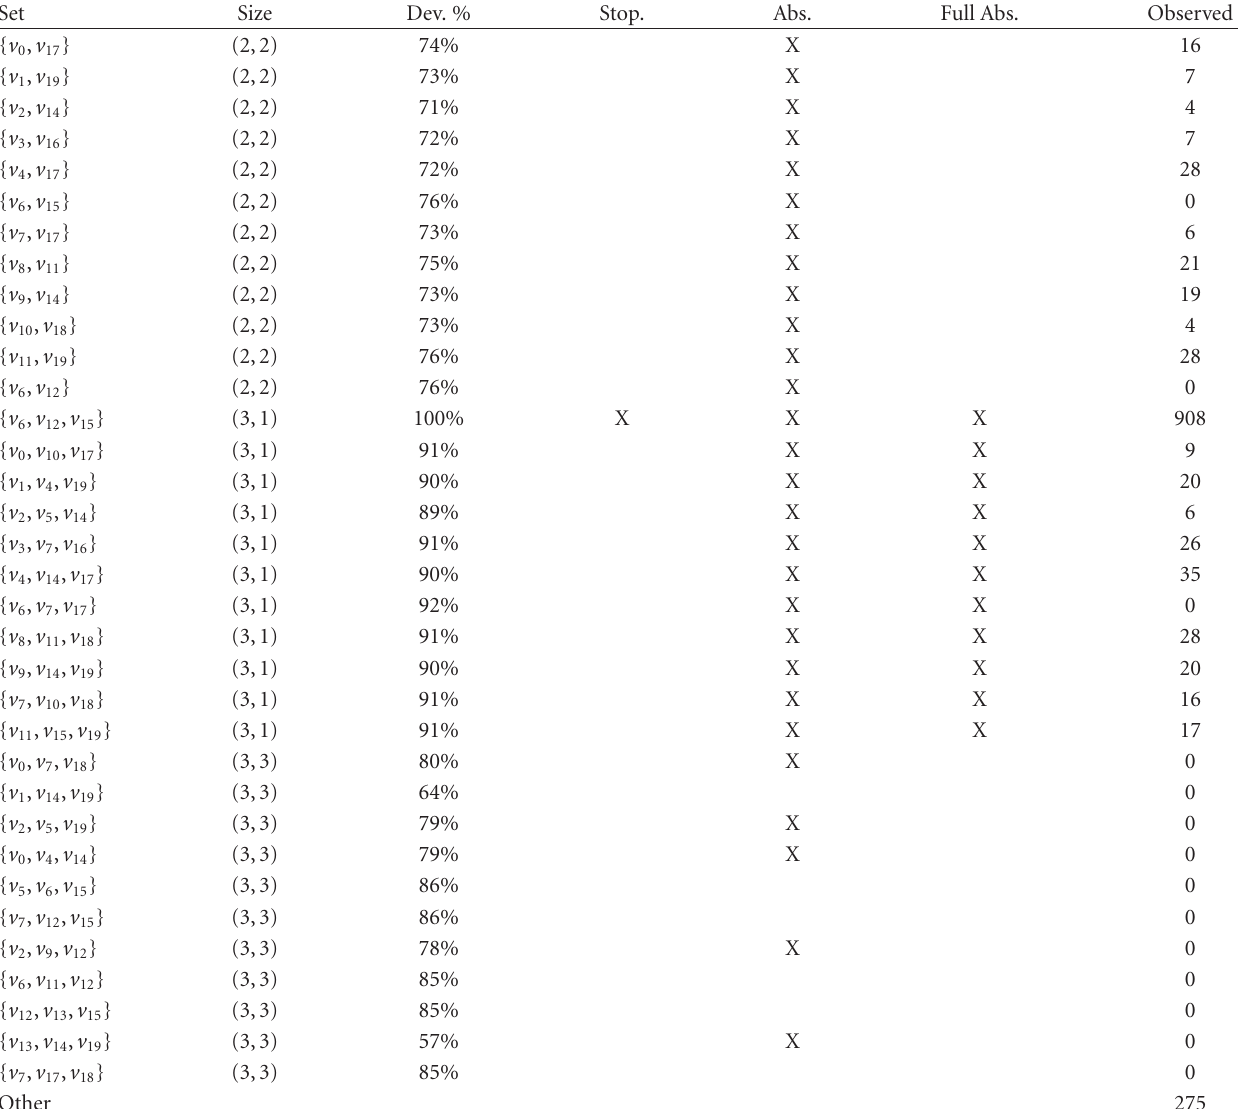
Table 3: Stopping/trapping/absorbing sets of a length N = 20, dimension K = 10, (3,6)-regular LDPC code with weight of 3 or less found using Algorithm 1, and the number of times they were observed after 1000 iterations of SP decoding at SNR = 8.0 dB. Set Size Dev. % Stop. Abs. Full Abs.